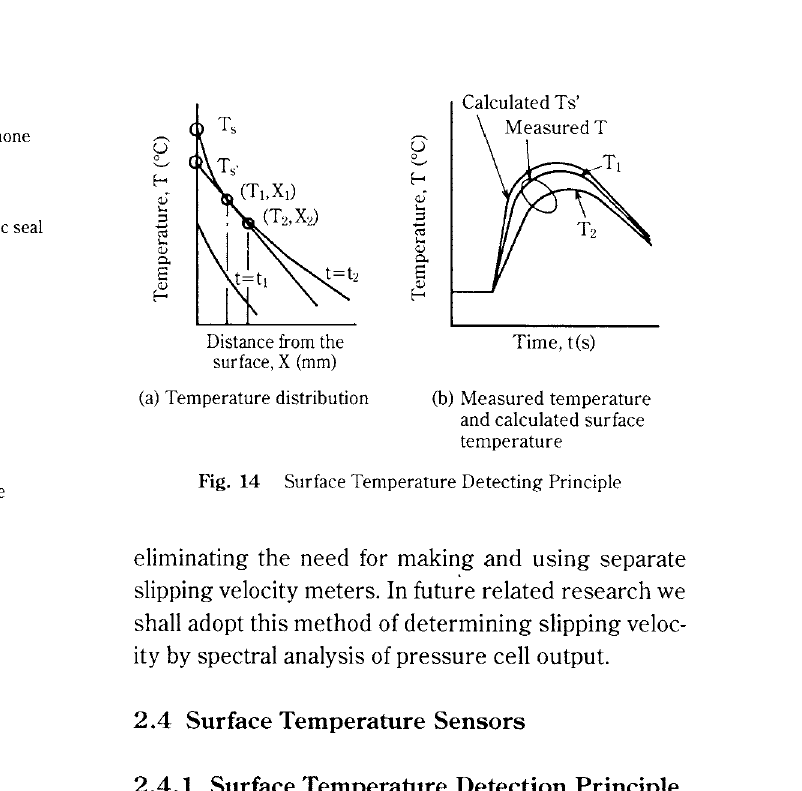
Fig. 12 Slipping Velocity Meter Using Microphone